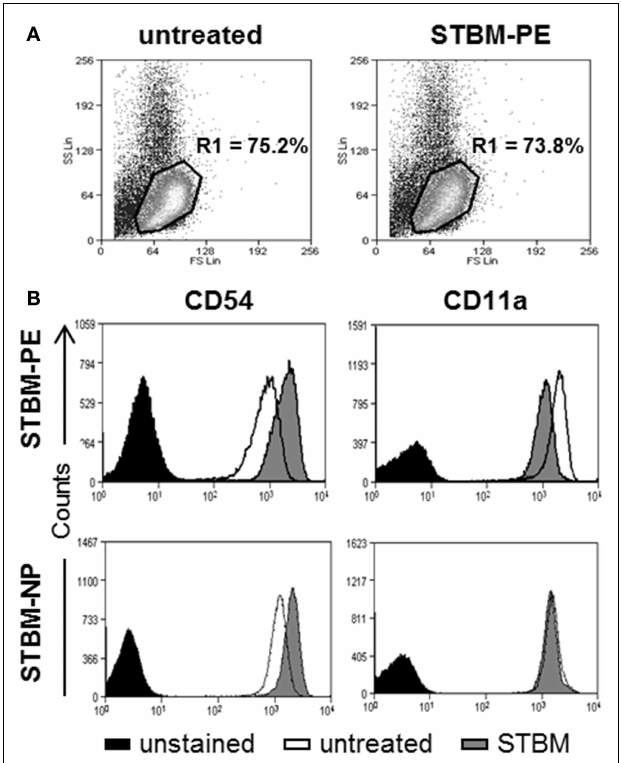
FIGURE 1 | STBM from normal and preeclamptic placentas alter the cell surface expression of CD54 and CD11a on monocytes. Primary human monocytes were left untreated or were co-cultured with 300 µ g/ml STBM prepared from normal (STBM-NP) or preeclamptic (STBM-PE) placentas for 16h.The cell surface expression of CD54 and CD11a was evaluated on CD14-positive cells using flow cytometry. (A) Representative forward/side scatter dot plots of untreated or STBM-treated cells. (B) Representative histograms of CD54 or CD11a expression on untreated or STBM-treated monocytes.The co-culture experiments were performed two times with five different STBM-NP preparations and three independent STBM-PE preparations.